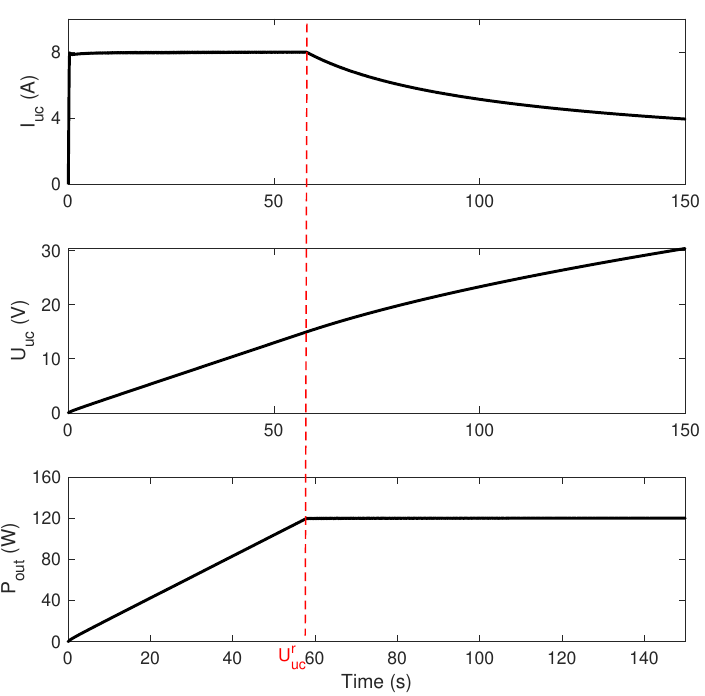
Figure 10. Current, voltage, and power of the